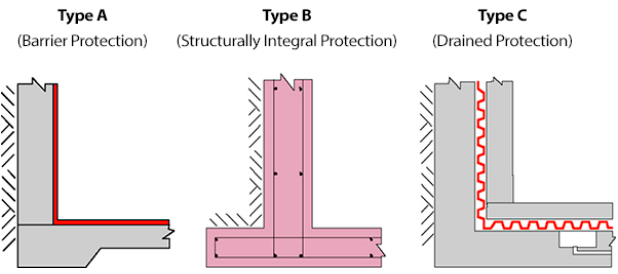
Figure 6. Waterproofing—BS.8102:2009 ‘Protection of below ground structures against water from the ground’ [3].